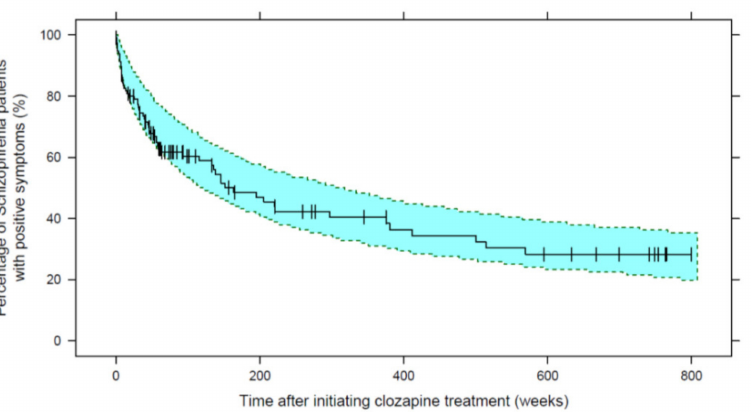
Figure 2. The final repeated time-to-event model of improving positive symptoms after the onset of clozapine treatment. The solid line represents the observed Kaplan–Meier survival plot while vertical lines mark censored observations with a mean time, (range) of 306 weeks (8–800). Shaded areas represent the 95% prediction interval from 1000 simulated